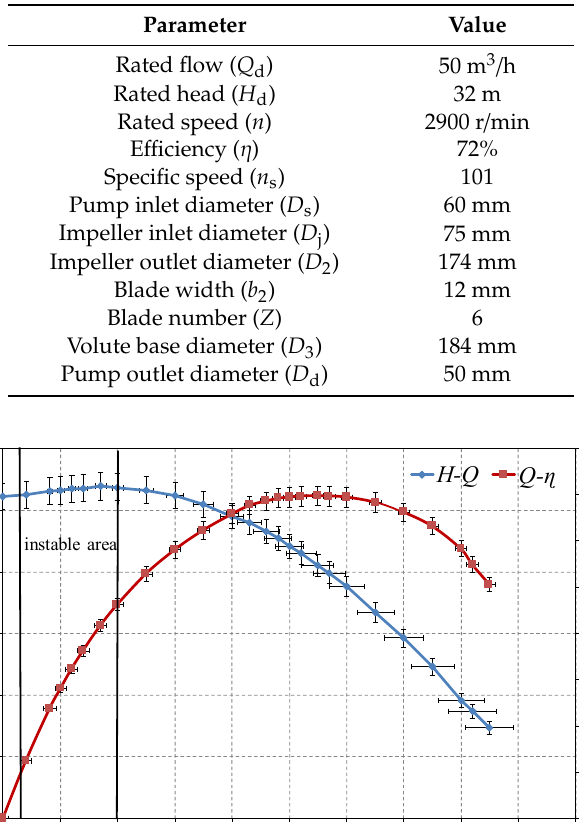
Table 1. Main parameters of the test centrifugal pump.